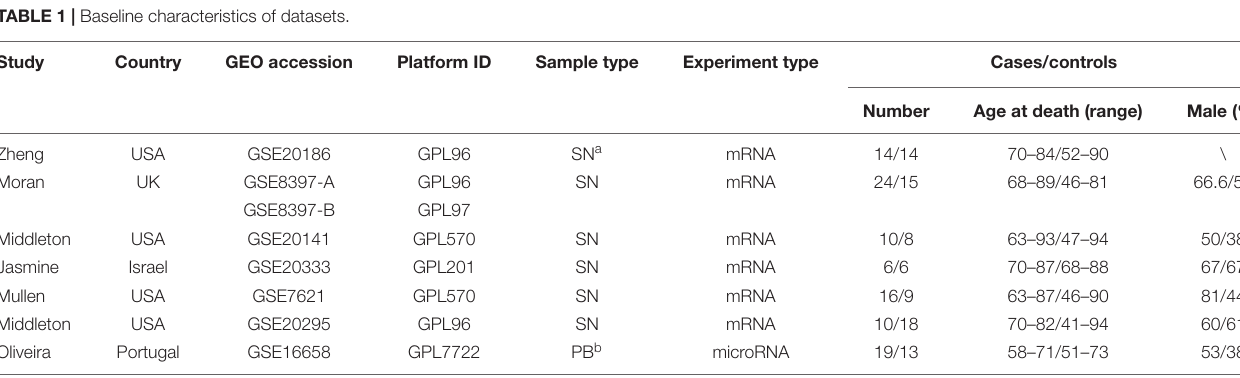
TABLE 1 | Baseline characteristics of